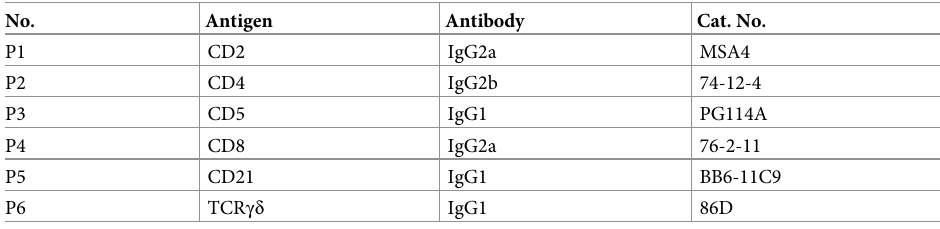
Table 1. Data of primary